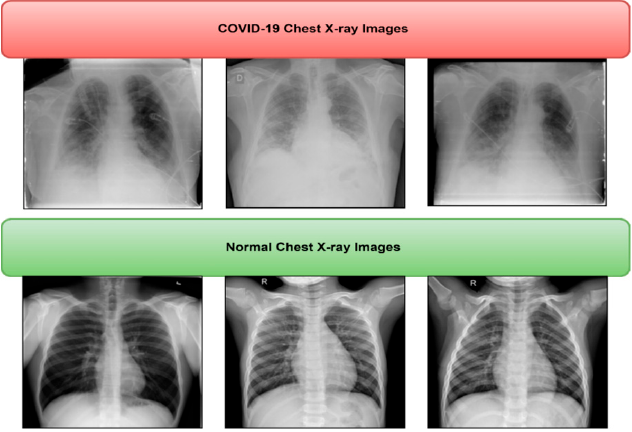
Figure 2. Sample of normal and COVID-19 radiograph images from Kaggle dataset. Table 2. Number of images in each class of COVID-19 database, with data augmentation and